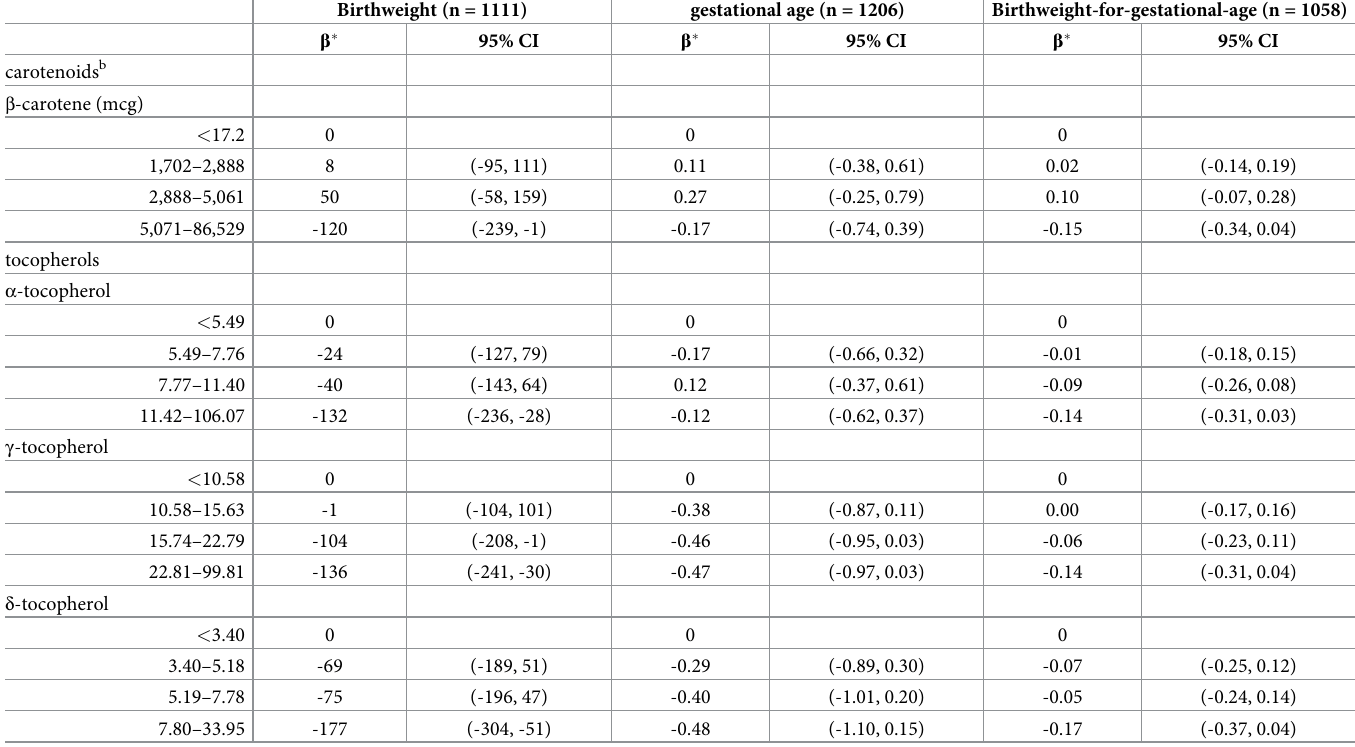
Table 7. Relationship between dietary intake of antioxidants and subsequent birth